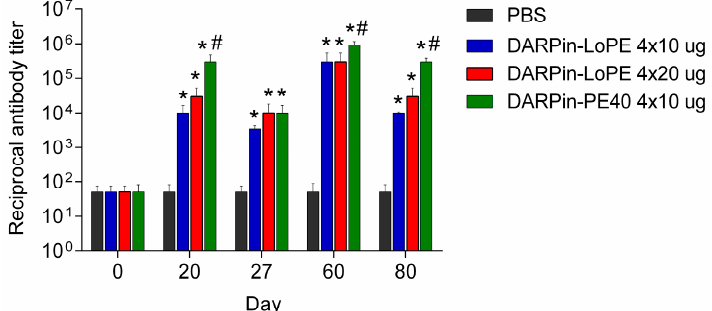
Figure 5. Dynamics of titers of antibodies specific to the targeted toxins. The day of the first injection of the targeted toxins was set as day 1. 0 is for the measurements of antibody titers in mice serum before the first treatment course started. PBS, mice treated with phosphate-buffered saline (control group); DARPin-LoPE 4 × 10 µg, mice treated with 10 µg DARPin-LoPE for 4 doses every other day (40 µg per course, 80 µg total); DARPin-LoPE 4×20 µg, mice treated with 20 µg DARPin-LoPE for 4 doses every other day (80 µg per course, 160 µg total); DARPin-PE40 4 × 10 µg, mice treated with 10 µg DARPin-PE40 for 4 doses every other day (40 µg per course, 80 µg total).“*” indicates a value that significantly differs from the respective control (PBS) value at p < 0.05; “#” indicates a value that significantly differs from the respective values in groups DARPin-LoPE 4 × 10 µg and DARPin-LoPE 4 × 20 µg at p < 0.05 (Student’s test with Bonferroni correction, n = 5). The data are represented as mean ± SEM